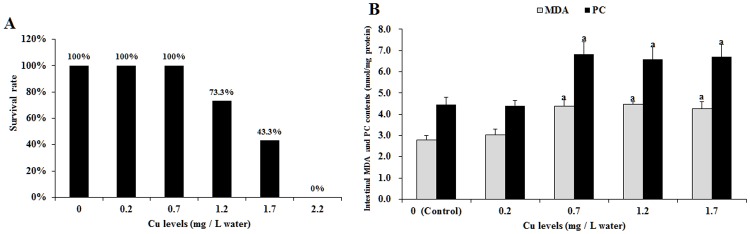
Cu induces oxidative stress in grass carp intestine. (A) The survival rate of young grass carp following copper exposure for 4 days. (B) The entire intestinal MDA and PC content of young grass carp following Cu exposure for 4 days.Values are expressed as the mean with standard deviation and are represented by vertical bars (n = 6). Superscript (a) indicates a significant (P < 0.05) difference over control values. MDA, malondialdehyde; PC, protein carbonyls.